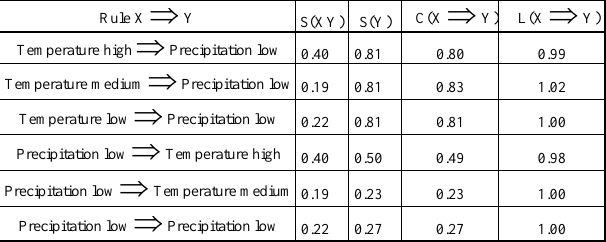
Table 2.the results of introducing lift of association rule mining(S is support, C is confidence, L is